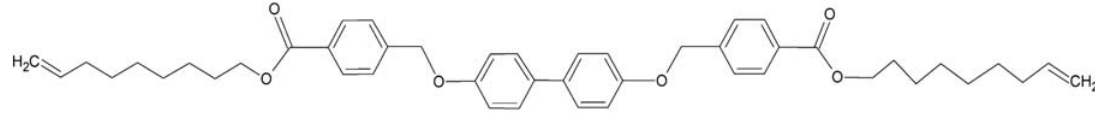
Table 1. Mesophase transitions determined by DSC (cooling rate of 5 K/min) of the sample labelled ‘C’. Phase transition temperatures (T, °C) and phase transition enthalpy ( Δ H, J/g) measured at the second DSC cycle are shown. The values of melting point (m.p.) and clearing point (c.p.) (measured on heating) are reported. m.p.